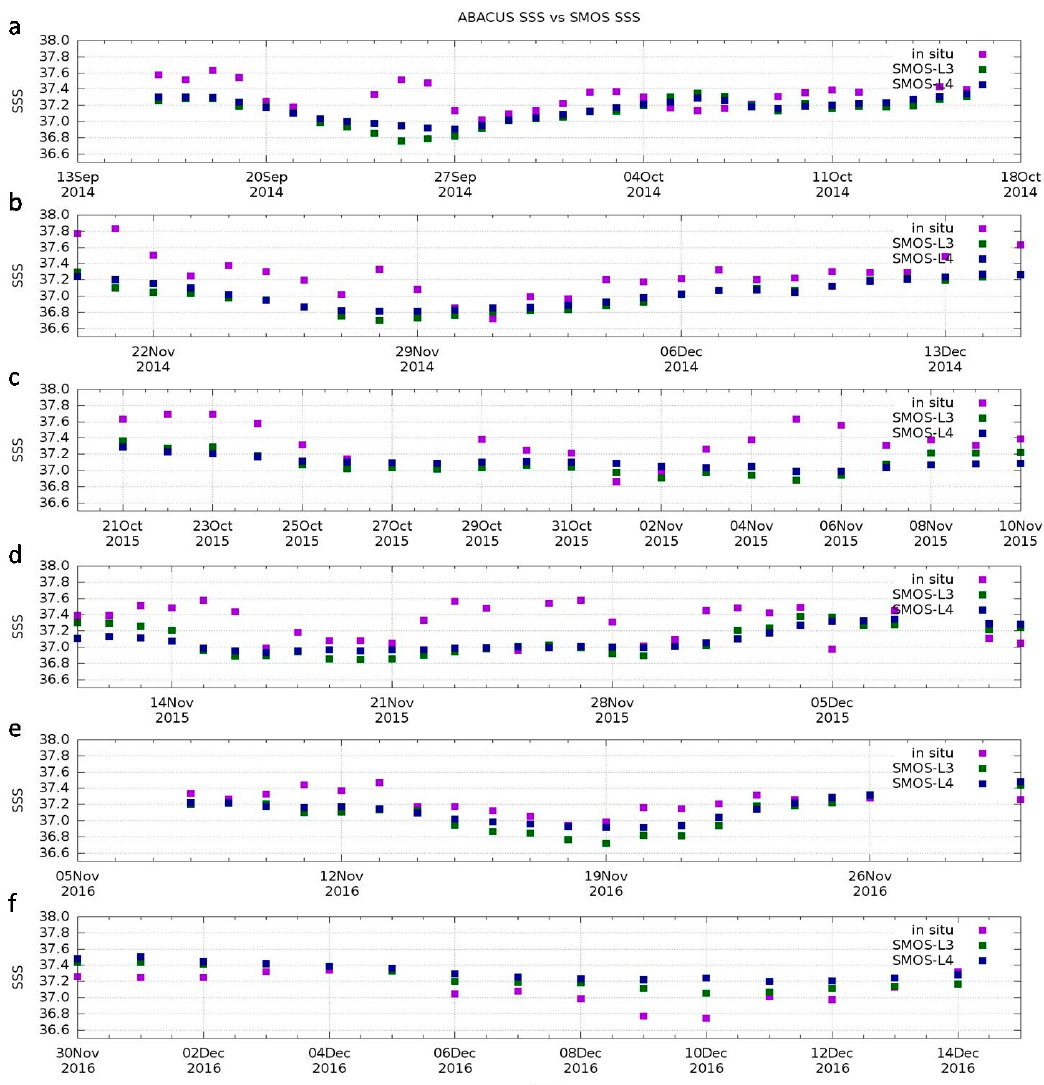
Figure 3. Comparison between averaged in situ glider salinities (purple dots) and SMOS L3 (green dots) and L4 (blue dots) SSS during the missions ( a ) ABACUS 1.1 (Sept–Oct 2014), ( b ) ABACUS 1.2 (Nov–Dec 2014), ( c ) ABACUS 2.1 (Oct–Nov 2015), ( d ) ABACUS 2.2 (Nov–Dec 2015), ( e ) ABACUS 3.1 (Nov 2016), and ( f ) ABACUS 3.2 (Dec 2016).